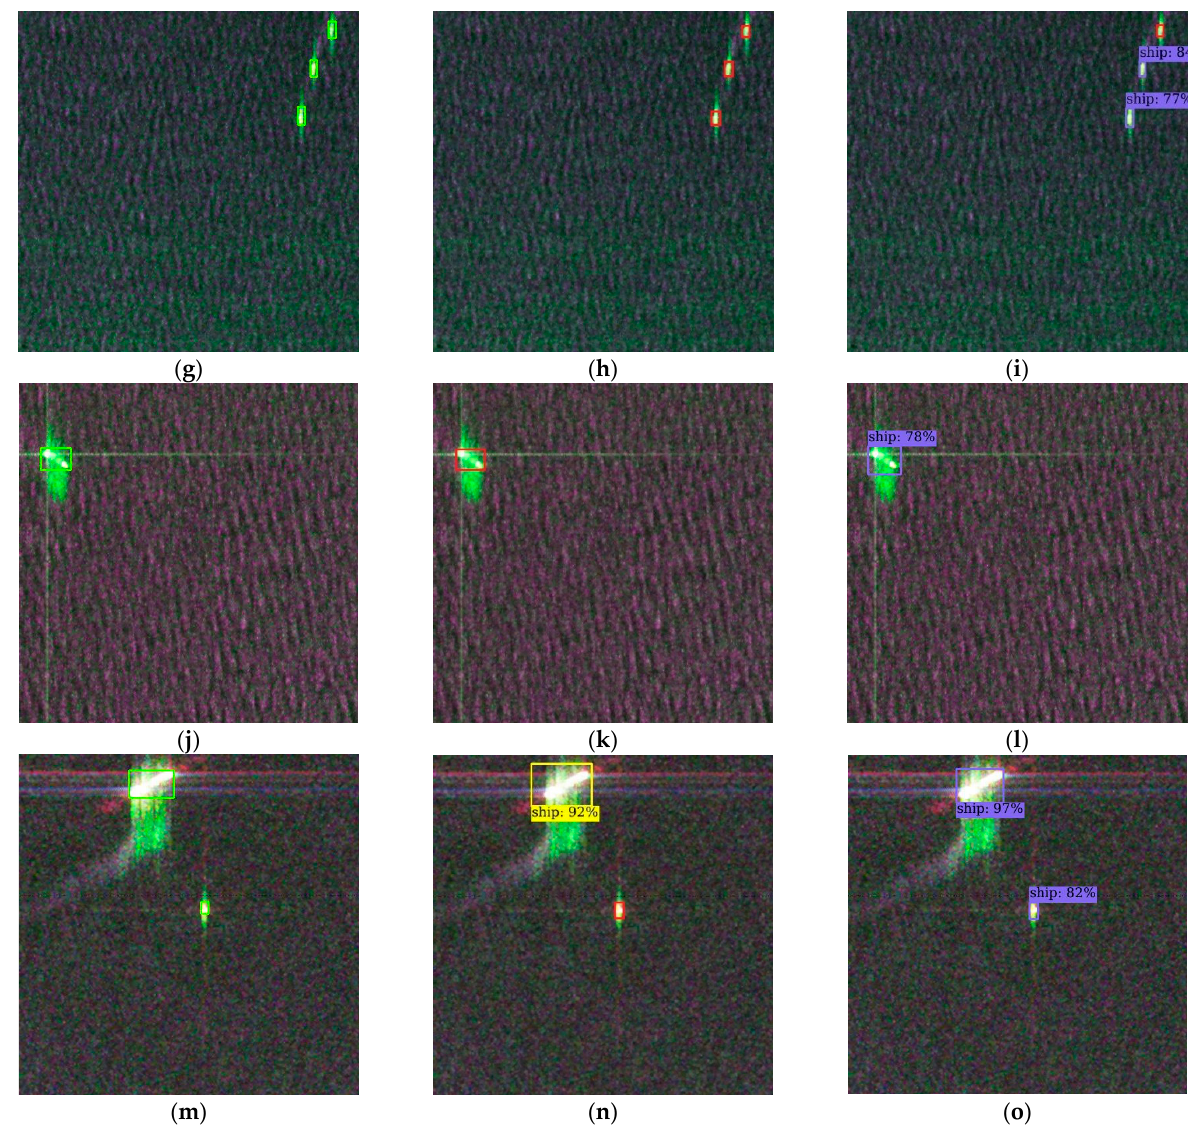
Figure 7. Ship detection results visualization: ( a , d , g , j , m ) the green rectangle represents the ground truth; ( b , e , h , k , n ) the yellow rectangle represents the detection results of train from scratch, and the red rectangle represents the missed detection; ( c , f , i , l , o ) the blue rectangle represents the detection results of train with our method, and the red rectangle represents the missed detection.